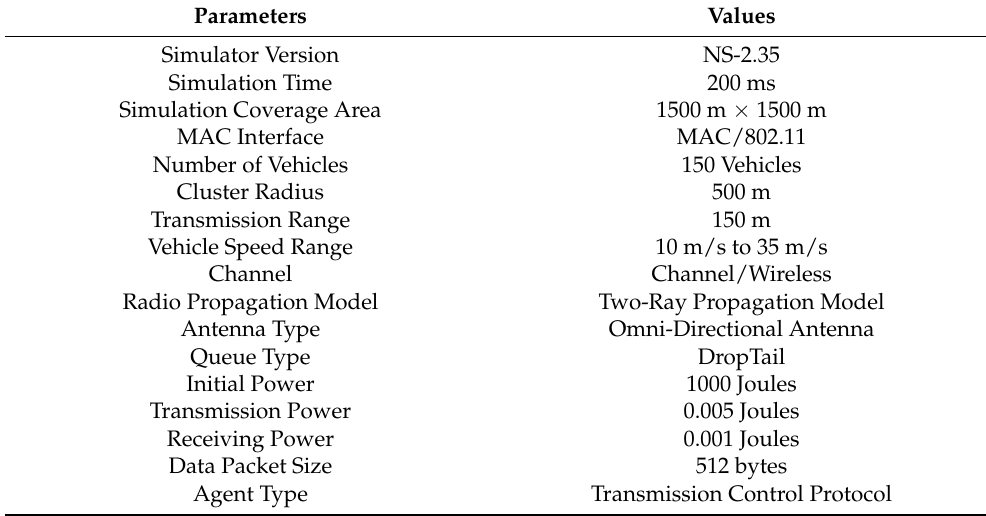
Table 4. Simulation